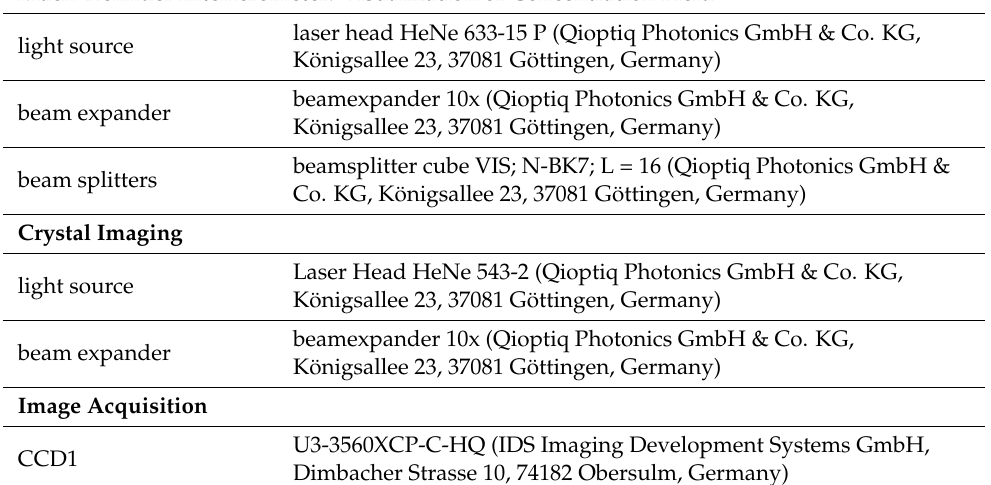
Table A1. Part list of the optical set-up. Mach–Zehnder Interferometer: Visualization of Concentration Field light